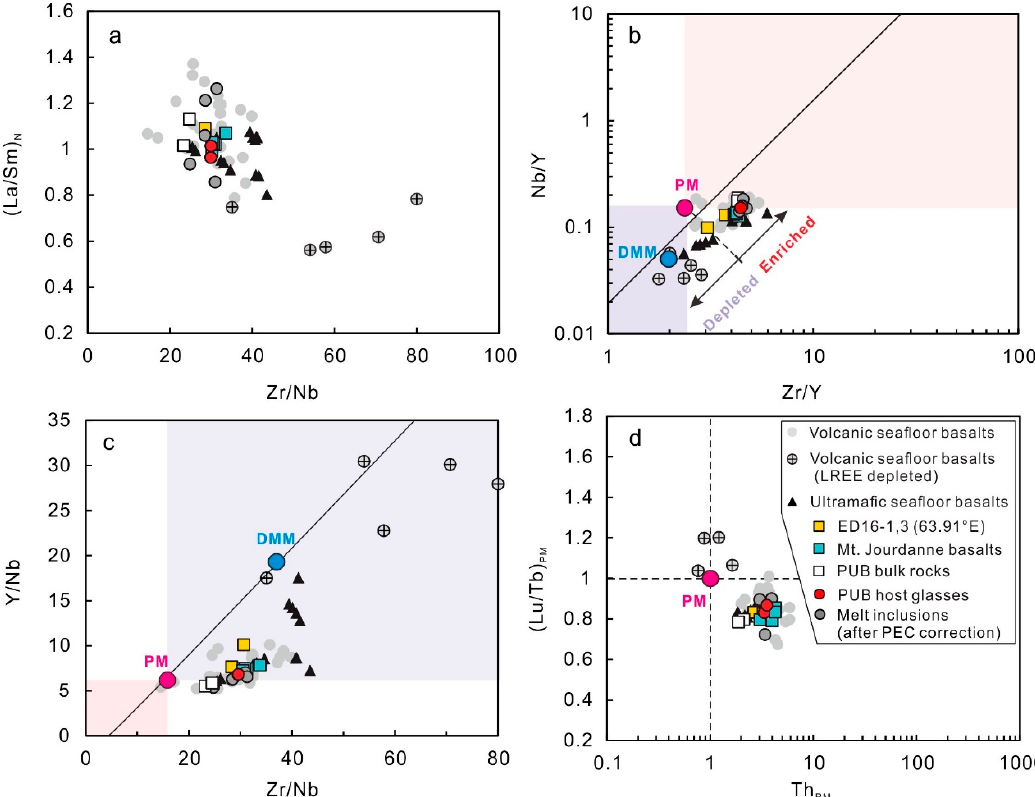
Figure 6. Binary plots in ( a ) chondrite-normalized (La / Sm) N versus Zr / Nb, ( b ) Nb / Y versus Zr / Y, ( c ) Y / Nb versus Zr / Nb and ( d ) primitive mantle normalized (Lu / Tb) PM versus Th PM diagrams for Mount Jourdanne basalts and PUBs, plagioclase-hosted melt inclusions and regional basalts from SWIR (61–67 ◦ E). Data for the 61–67 ◦ E basalts are from Paquet et al. [30]. The value for chondrite is from Sun and McDonough [46] and for primitive mantle (PM) is from McDonough and Sun [47]. In panels ( b ) and ( c ), the pink color indicates enriched samples with the ratios Nb / Y and Zr / Y > PM and Y / Nb and Zr / Nb < PM. The light blue color indicates depleted samples with Nb / Y and Zr / Y < PM and Y / Nb and Zr / Nb > PM. Boundary line between plume and non-plume sources in ( b ) and ( c ) are from Fitton et al. [55]. Composition of depleted MORB mantle (DMM) is from Condie [56].